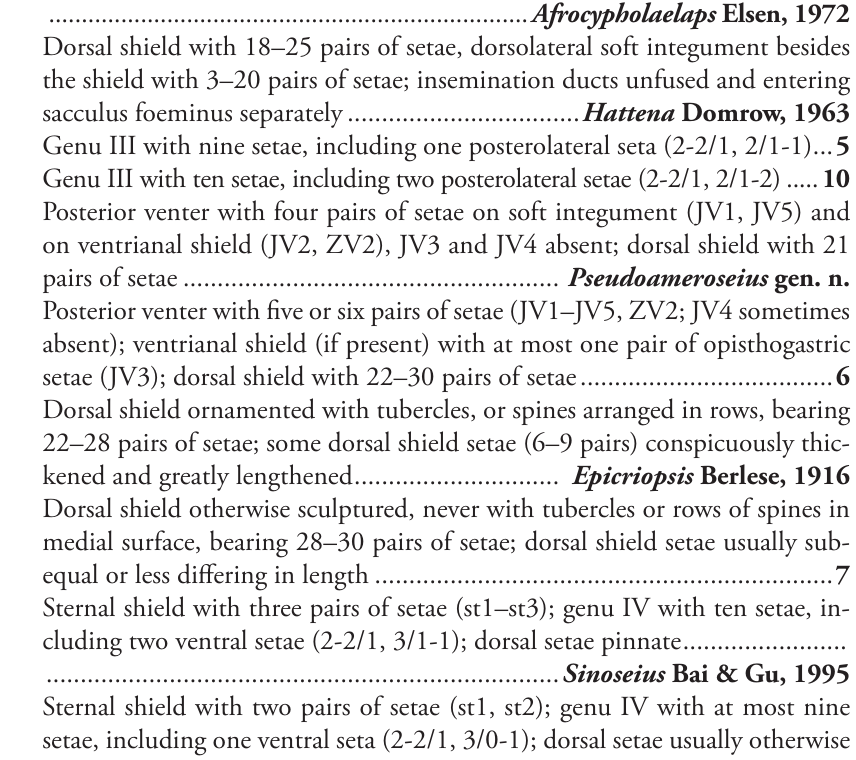
– Dorsal shield with 18–25 pairs of setae, dorsolateral soft integument besides the shield with 3–20 pairs of setae; insemination ducts unfused and entering sacculus foeminus separately .................................. Hattena Domrow, 1963 4 Genu III with nine setae, including one posterolateral seta (2-2/1, 2/1-1) ... 5 – Genu III with ten setae, including two posterolateral setae (2-2/1, 2/1-2) ..... 10 5 Posterior venter with four pairs of setae on soft integument (JV1, JV5) and on ventrianal shield (JV2, ZV2), JV3 and JV4 absent; dorsal shield with 21 pairs of setae ....................................................... Pseudoameroseius gen. n. – Posterior venter with five or six pairs of setae (JV1–JV5, ZV2; JV4 sometimes absent); ventrianal shield (if present) with at most one pair of opisthogastric setae (JV3); dorsal shield with 22–30 pairs of setae ..................................... 6 6 Dorsal shield ornamented with tubercles, or spines arranged in rows, bearing 22–28 pairs of setae; some dorsal shield setae (6–9 pairs) conspicuously thic- kened and greatly lengthened .............................. Epicriopsis Berlese, 1916 – Dorsal shield otherwise sculptured, never with tubercles or rows of spines in medial surface, bearing 28–30 pairs of setae; dorsal shield setae usually sub- equal or less differing in length ................................................................... 7 7 Sternal shield with three pairs of setae (st1–st3); genu IV with ten setae, in- cluding two ventral setae (2-2/1, 3/1-1); dorsal setae pinnate ........................ ........................................................................... Sinoseius Bai & Gu, 1995 – Sternal shield with two pairs of setae (st1, st2); genu IV with at most nine setae, including one ventral seta (2-2/1, 3/0-1); dorsal setae usually otherwise formed ........................................................................................................ 8 8 Some dorsal shield setae (6–7 pairs) inserted on distinct protuberances, these setae longer, thicker and more heavily pilose than those on flat surface; tibia IV with ten setae, including two posterolateral setae (2-2/1, 2/1-2); fixed di- git of chelicera slender, straight, with three sharp teeth and widened bilobed tooth close to terminal hook (Plate 77F) ... Asperolaelaps Womersley, 1956 – Dorsal shield setae not inserted on protuberances; tibia IV with nine setae, including one posterolateral seta (2-2/1, 2/1-1); fixed digit of chelicera more robust, at least slightly curved, without subterminal bilobed tooth.............. 9 9 Cheliceral digits slender and terminally hooked: fixed digit edentate or with one weak tooth, having hyaline lobed appendage; corniculi slender and conver- gent, with undivided and pointed apex ...... Neocypholaelaps Vitzthum, 1942 – Cheliceral digits robust and straight: fixed digit well dentate, normally with three teeth on proximal masticatory area (rarely with one robust tooth or two denticles), never with hyaline lobed appendage; corniculi stouter and parallel, with bi- or trifid apex .......................................... Ameroseius Berlese, 1904 10 Tarsus I without ambulacrum and claws, bearing greatly lengthened sensory setae; posterior venter with anal shield bearing only three circum-anal setae